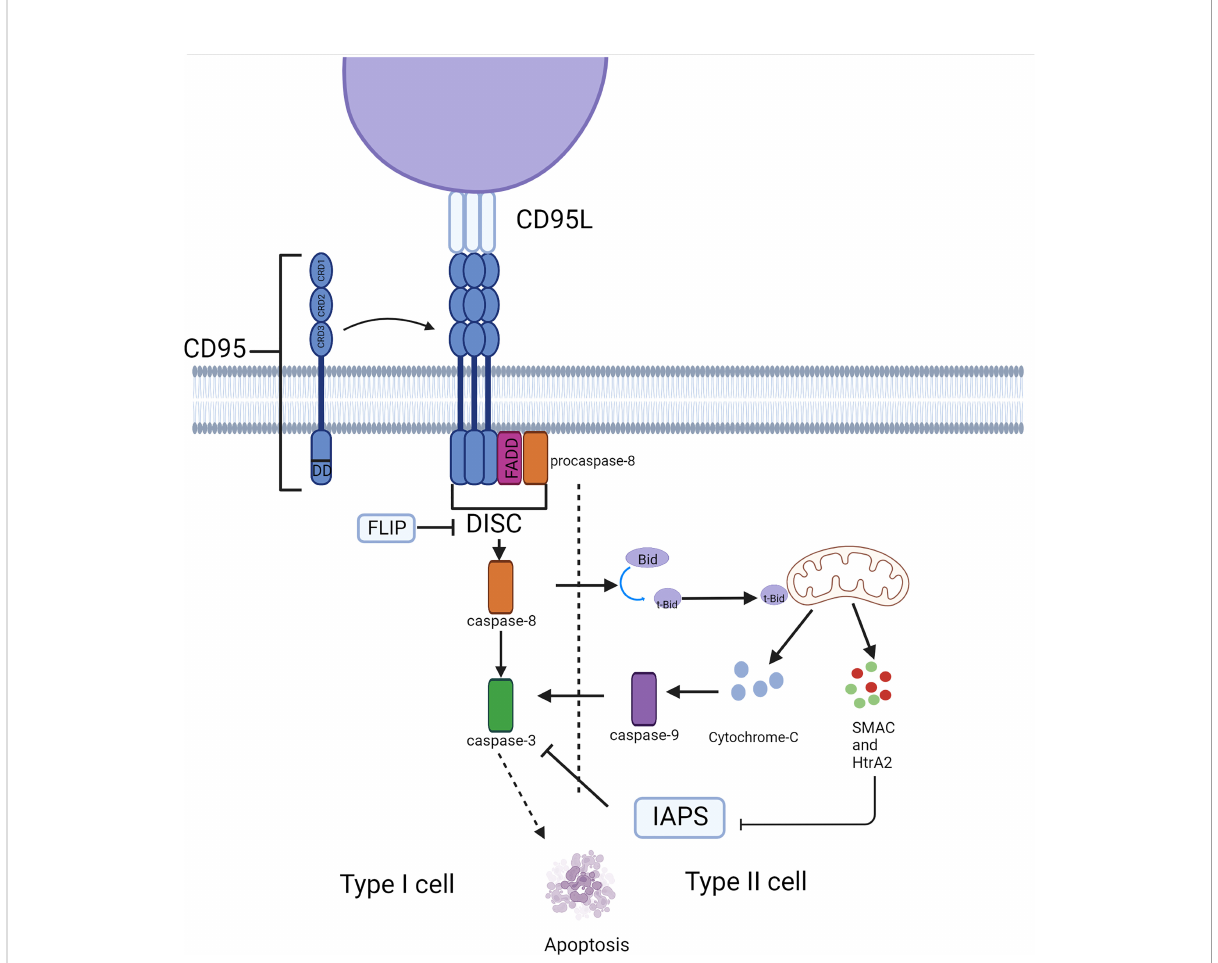
FIGURE 1 Typical apoptosis signaling pathway mediated by CD95. CD95 induces cell apoptosis through the caspase cascade in different cell types. This process depends on the involvement of mitochondria in type II